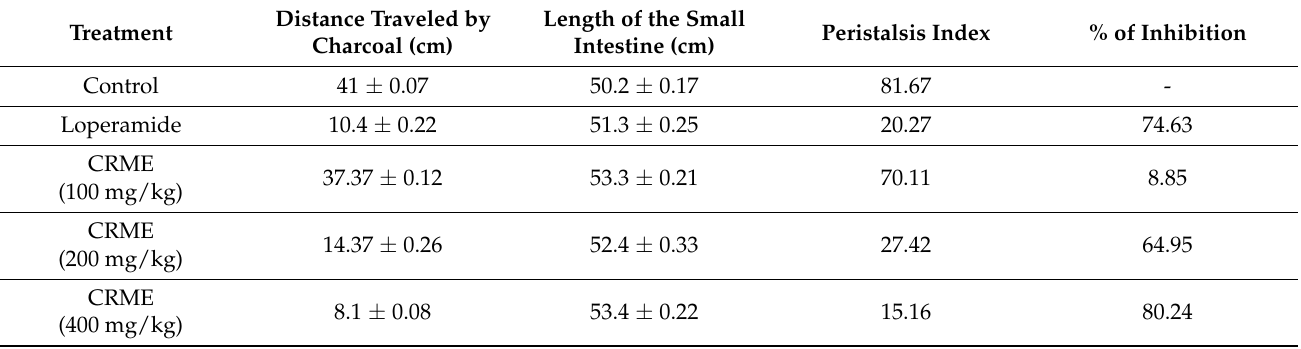
Table 7. Impact of CRME on the intestinal transit of charcoal in